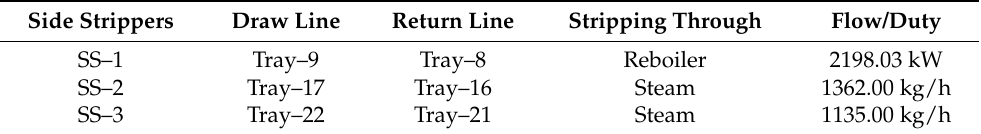
Table 3. Specifications for Side-Strippers [21].